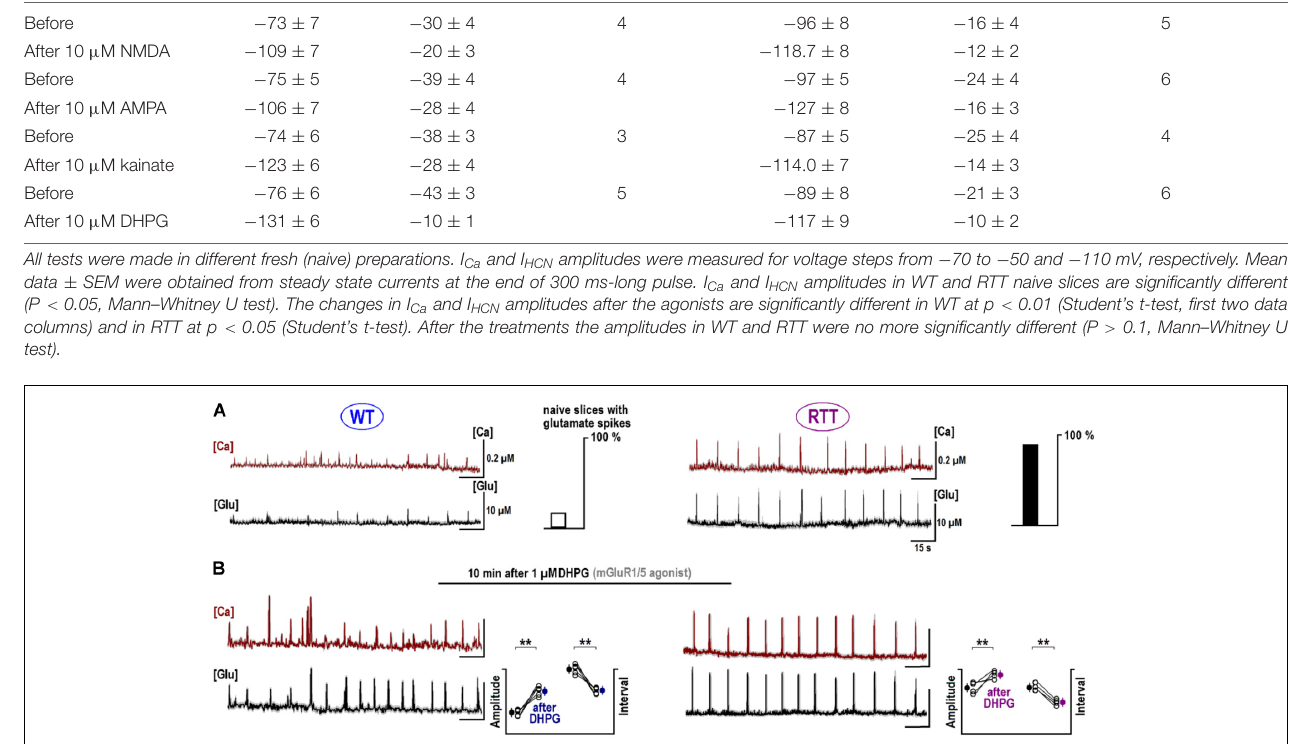
TABLE 3 | Amplitudes of calcium and HCN-currents in CA1 neurons in slices from WT and RTT animals. WT RTT I Ca I HCN Number of tests I Ca Number of tests